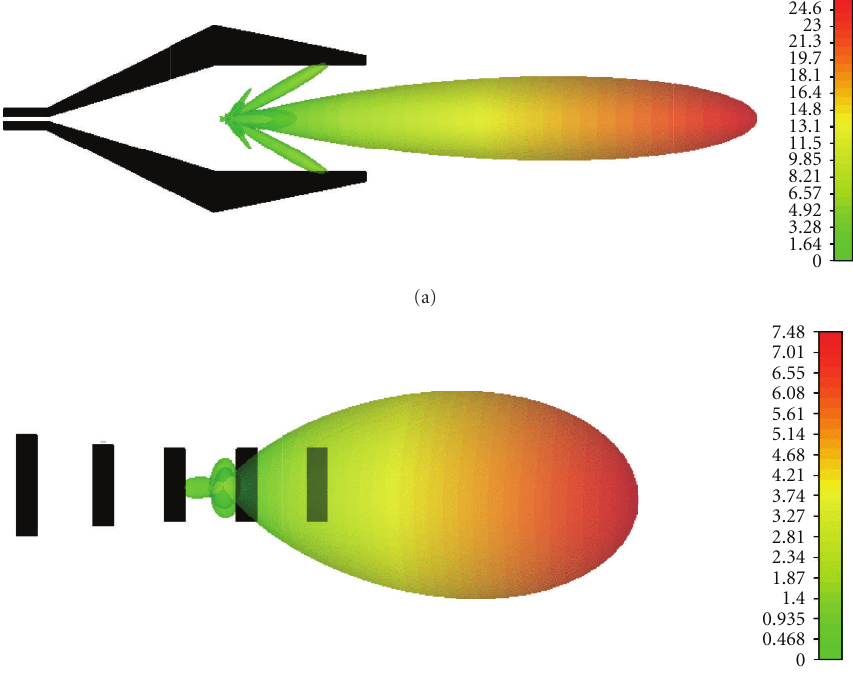
Figure 5: Comparison of simulated directivity (linear scale) far-field radiation patterns for (a) new directional nanoantennas designed in this work, and (b) Yagi-Uda type nanoantennas from [18]. Both nanoantennas are shown in top